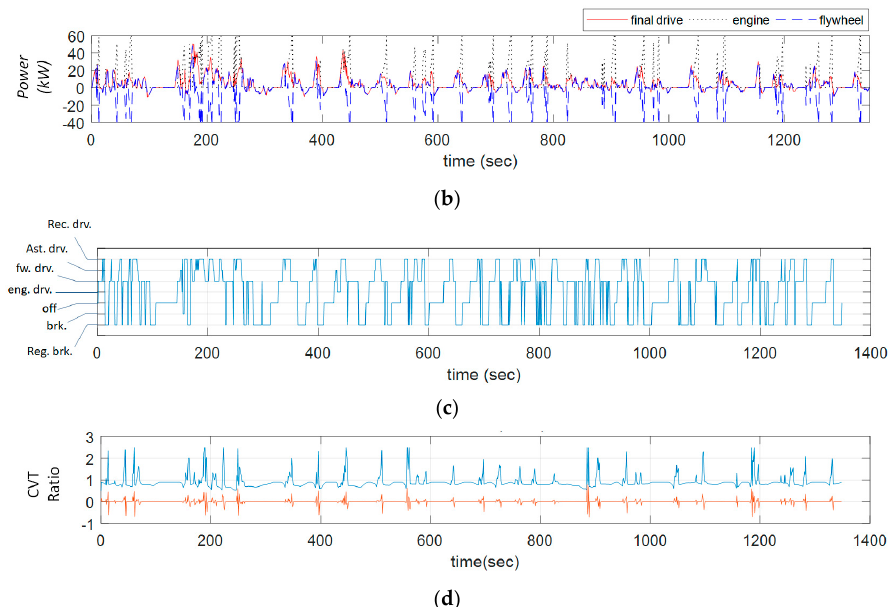
Figure 18. PS-FHV UDDS drive cycle result: ( a ) speed profile; ( b ) power profile; ( c ) driving mode profile; and ( d ) CVT ratio and shift speed profile.